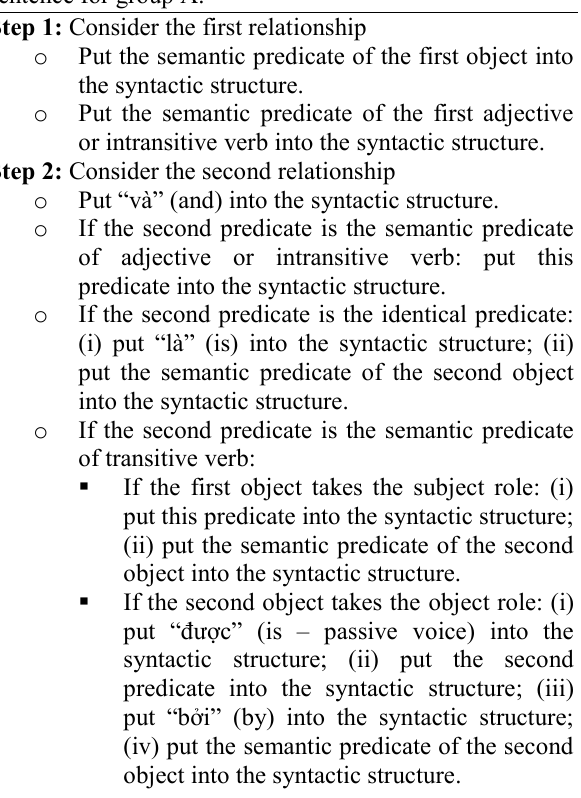
Algorithm 7 : Generate the syntactic structure of new sentence for group A.